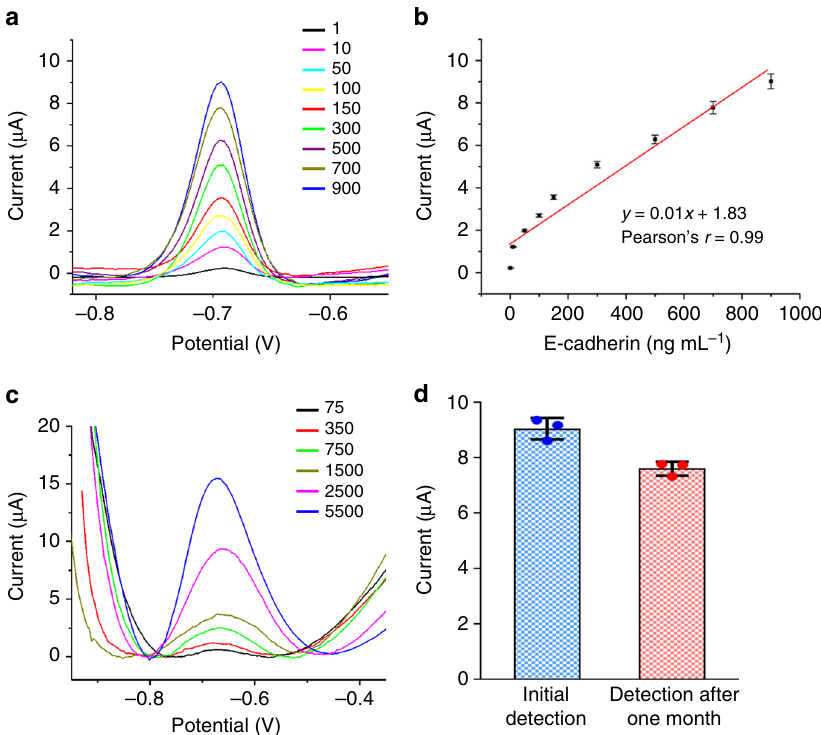
Fig. 4 Detection of E-cadherin at different protein levels and with different amount of cells. a DPV detection of varying concentrations (1 – 900 ng mL − 1 ) of puri fi ed E-cadherin protein. b Calibration curve showing the linear relationship of the biosensor in detection of E-cadherin. c DPV detection of varying amount of A549 cells. d Measurement of the stability of the biosensor for detecting E-cadherin. Current responses were obtained using the initial E-cad- QD probe and the probe stored for 1 month. Error bars represent ± s.d. ( n = 3). Source data are provided as a Source Data fi